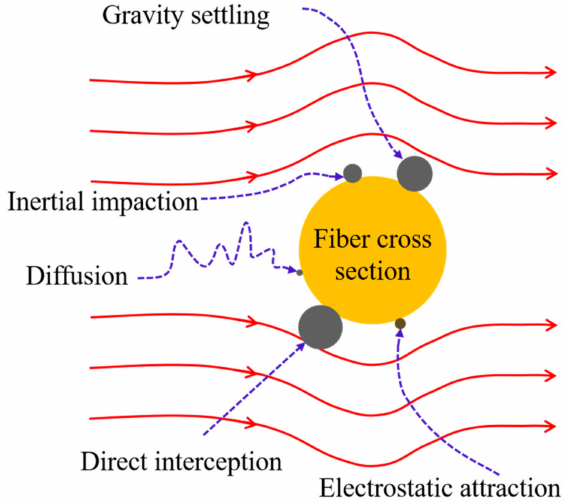
Figure 1. Single fiber filtration mechanism.